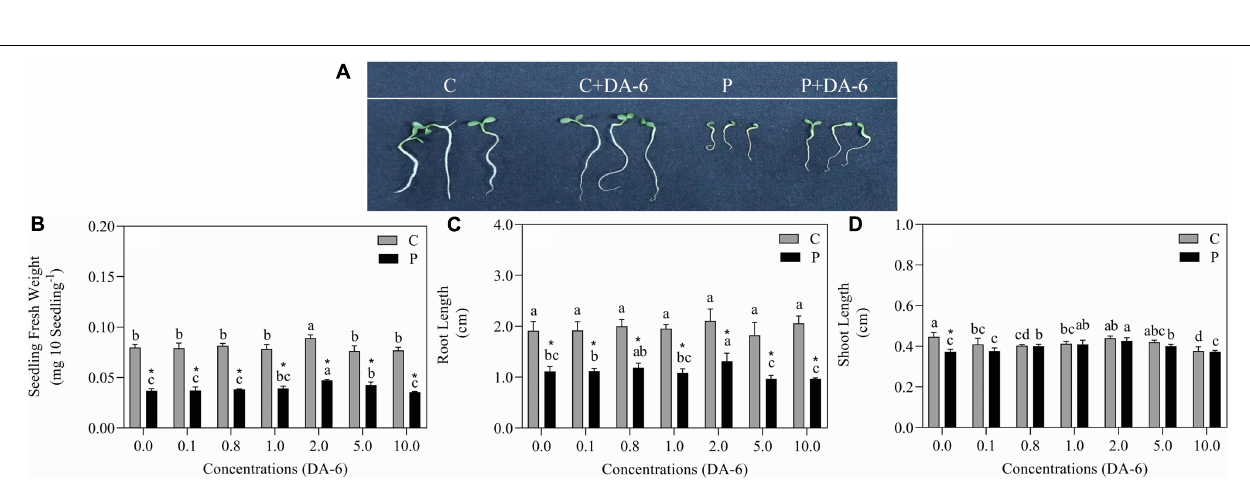
FIGURE 1 | Effect of seed priming with different concentrations of DA-6 on (A) germination percentage (GP), (B) germination vigor (GV), (C) germination index (GI), (D) mean germination time (MGT) and (E) seed vigor index (SVI) during 7 days of germination in white clover under well-watered condition and drought stress. Different letters represent significant differences among treatments with the application of different concentrations of DA-6 under well-watered condition or drought stress ( p ≤ 0.05). Vertical bars show the ± SE of mean ( n = 6), whereas *indicates significant difference between well-watered condition and drought stress under one particular concentration of DA-6.